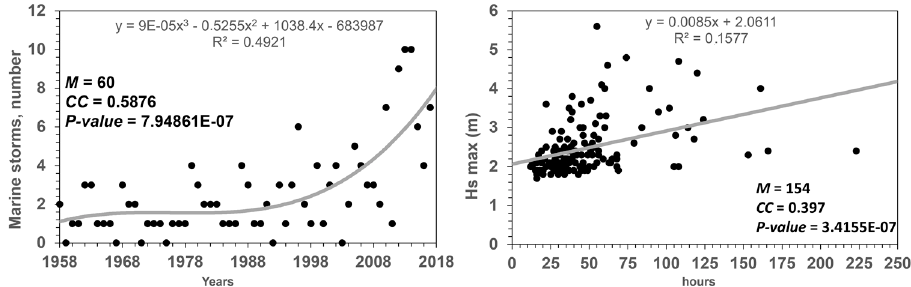
Figure 4. Evolution of the number of sea storm events between 1958 and 2018 (sixty years) (polynomial trend) ( left ) and correlation between maximum wave height (Hs max) and storm duration (linear trend) ( right ). M is the sample size and CC is the correlation coefficient.